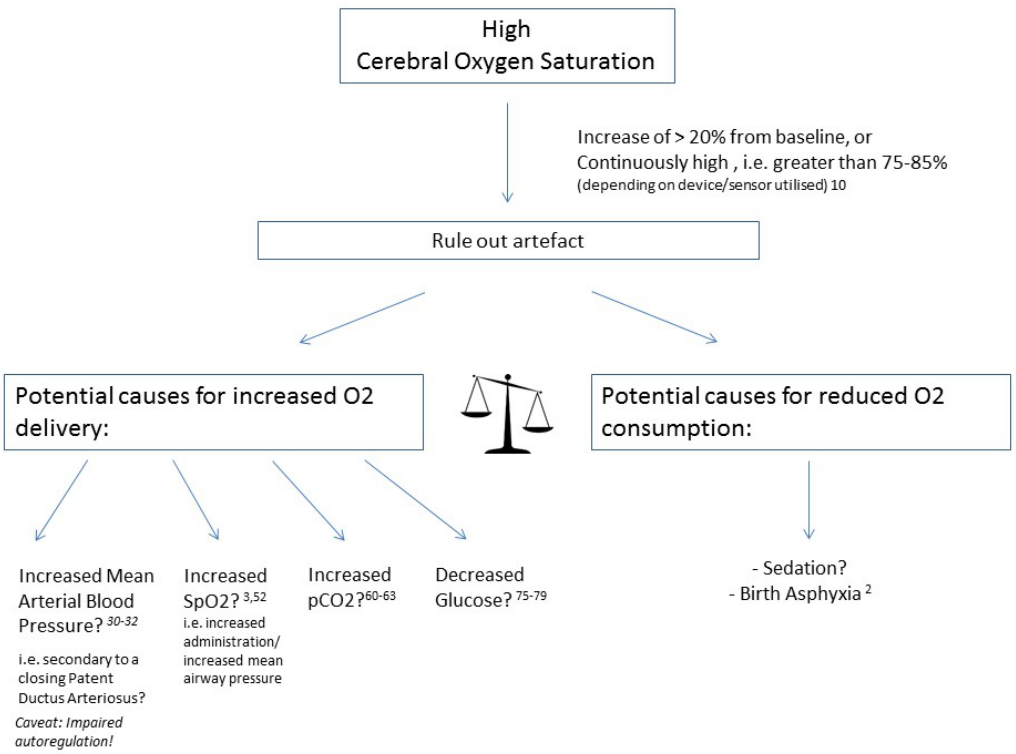
Figure 2. Causes of high cerebral oxygen saturation.